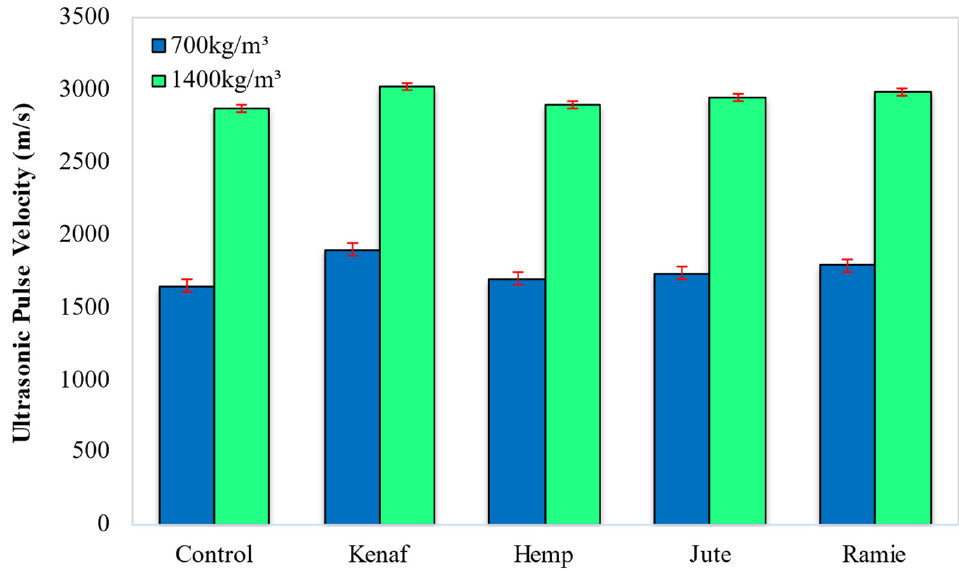
Figure 8. Effect of different types of fiber on ultrasonic pulse velocity of LFC.